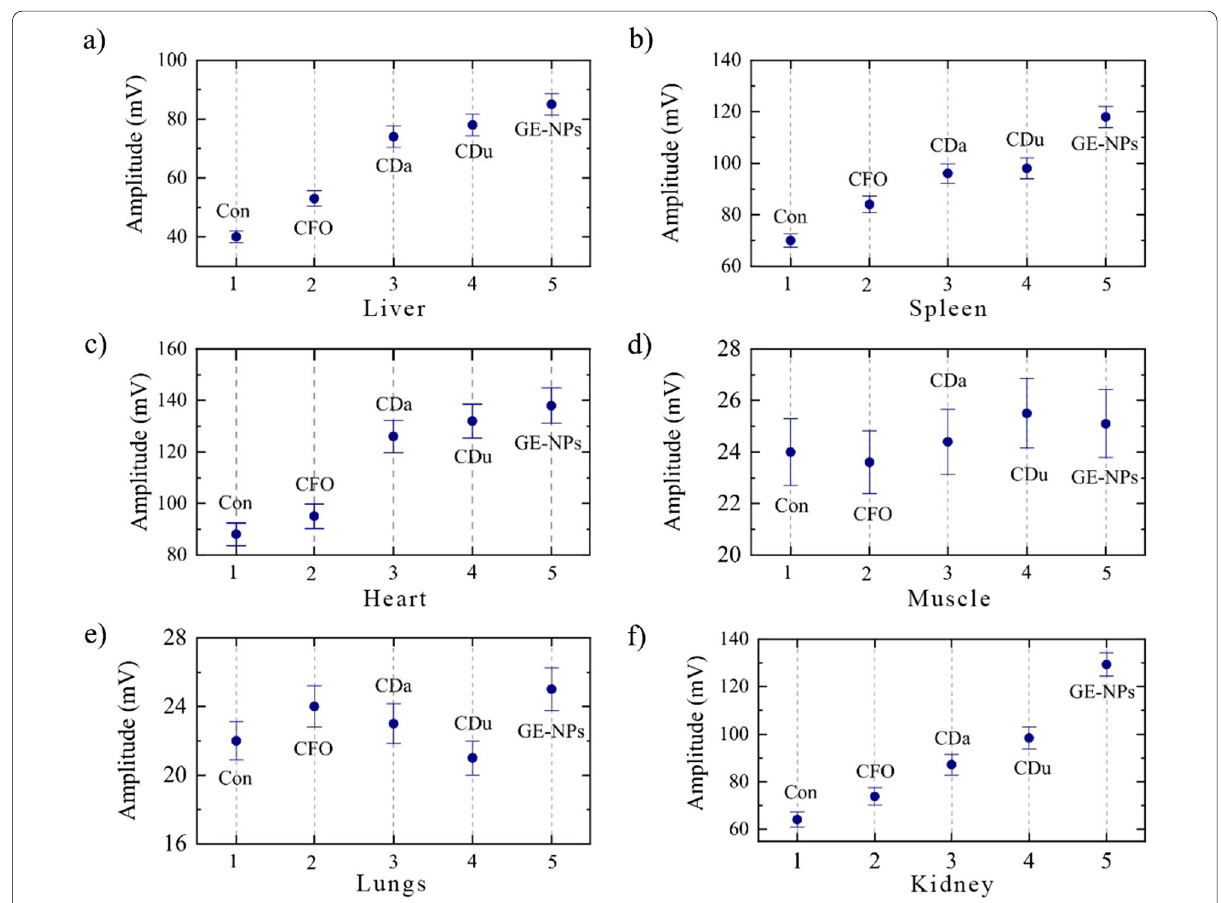
Fig. 5 Averaged signal amplitude recorded on a liver, b spleen, c heart, d gastrocnemius muscle samples, e lungs, f kidney. Con: control, CFO: carbon flurooxide nanoparticles; CDa: carbon nanodots from β -alanine; CDu: carbon nanodots from urea-citric acid; GE-NPs: glucose-ethylenediamine nanoparticles